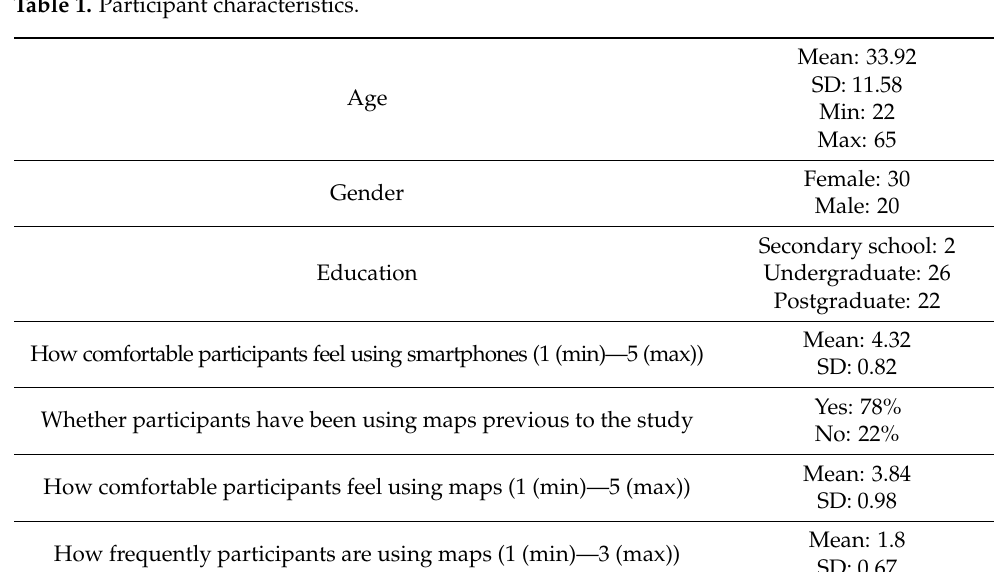
Table 1. Participant characteristics.